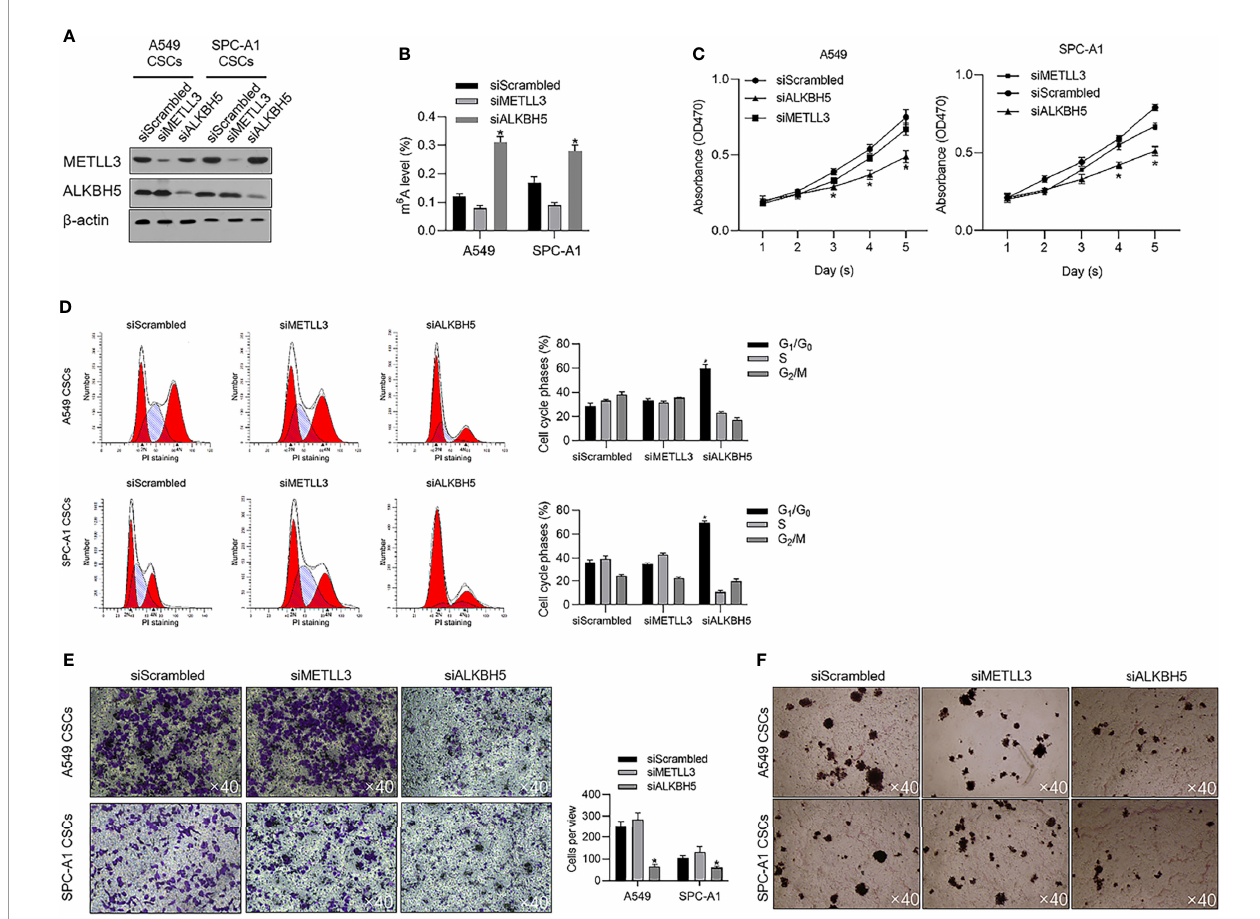
FIGURE 3 | ALKBH5 is tightly associated with global m 6 A methylation level and promotes cell cycle progression and invasive capacity. (A) Ef fi cient knockdown of METTL3 or ALKBH5 was con fi rmed by performing a Western blot analysis. (B) After METTL3 or ALKBH5 knockdown, the global m 6 A methylation was measured. (C) After METTL3 or ALKBH5 knockdown, cell viability from days 1 to 5 was measured by performing CCK-8 assay. * p < 0.05 vs. the siScrambled group. (D) After METTL3 or ALKBH5 knockdown, the cell cycle distribution was measured by performing PI staining followed by fl ow cytometric analysis. * p < 0.05 vs. siScrambled group. After METTL3 or ALKBH5 knockdown, invasive capacity (E) or tumor formation in soft agar (F) was respectively